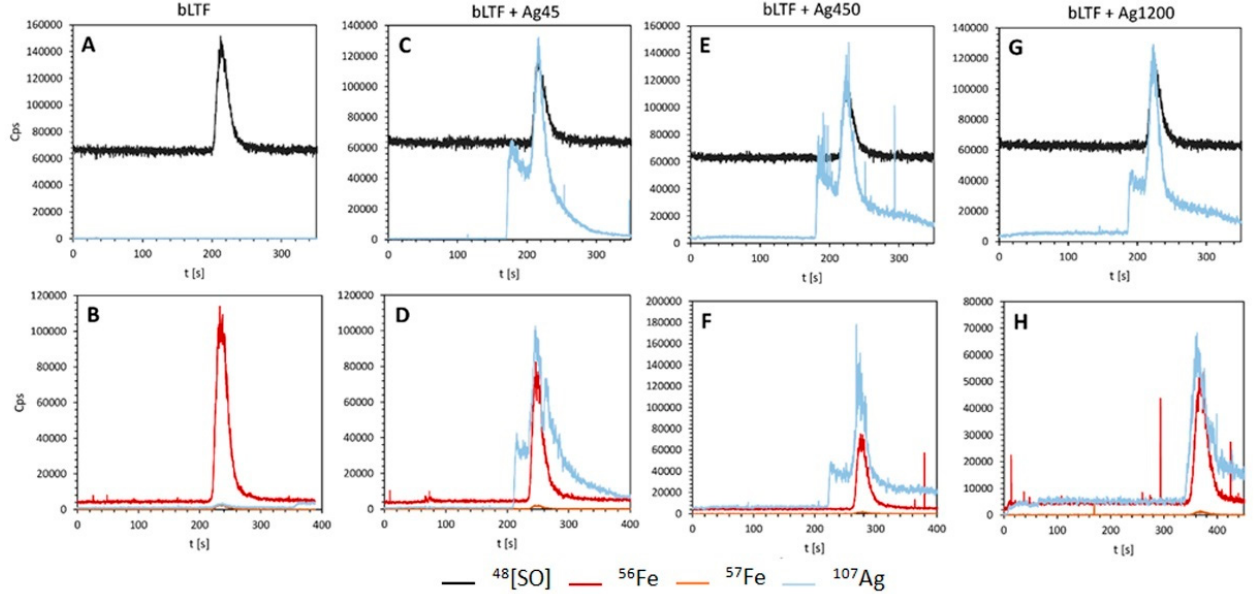
Figure 9. Electropherograms obtained using CE-ICP MS system for native bLTF ( A , B ) and AgLTF45 ( C , D ), AgLTF450 ( E , F ), and AgLTF1200 ( G , H ), after applying as a DRC gas oxygen ( A , C , E , G ) or ammonia ( B , D , F , H ).